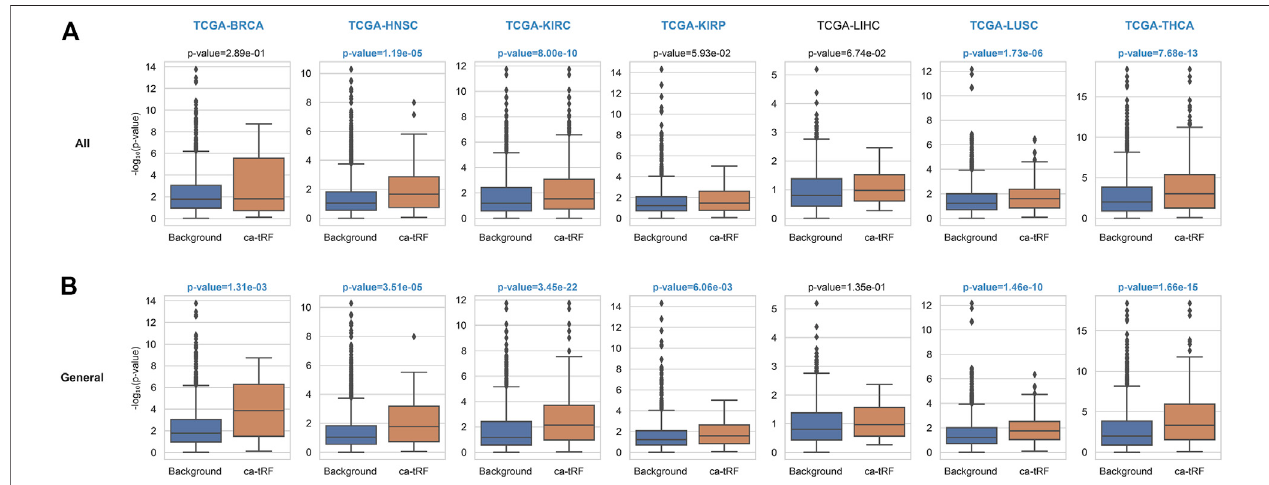
FIGURE 6 | ca-tRFs are more likely to be correlated with T-cell in fi ltration. The correlation of tRF expression and T-cell in fi ltration degree are measured by Spearman ’